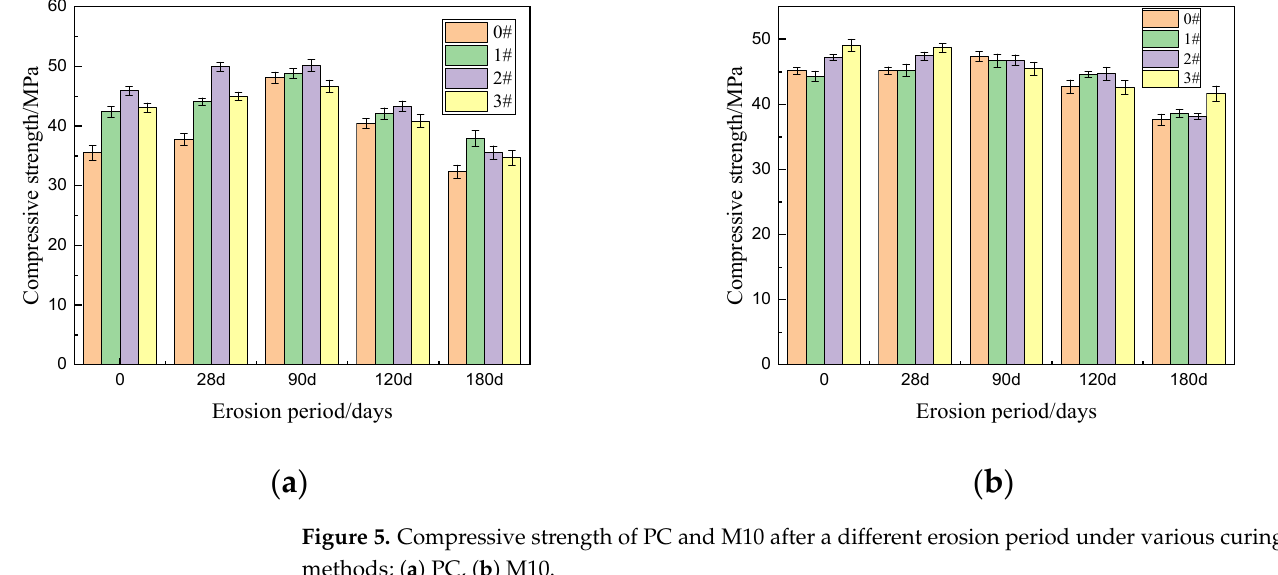
methods; ( a ) PC, ( b ) M10.